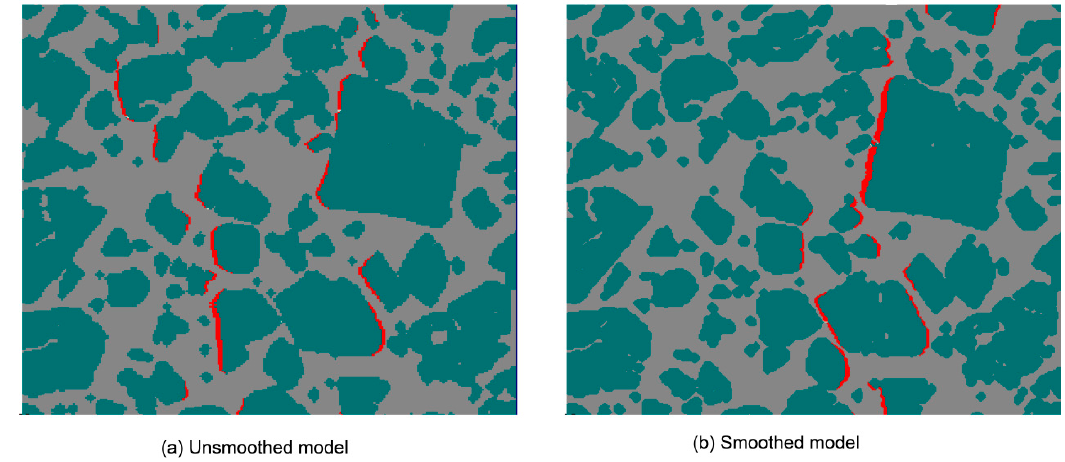
Figure 14. Cracks due to debonding in the unsmoothed and smoothed model under uniaxial tension: ( a ) unsmoothed model; ( b ) smoothed model.